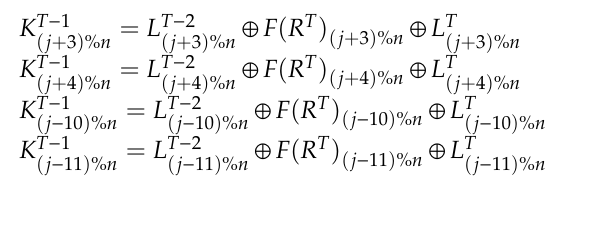
Table 4. The relationship between the bit L T − 2